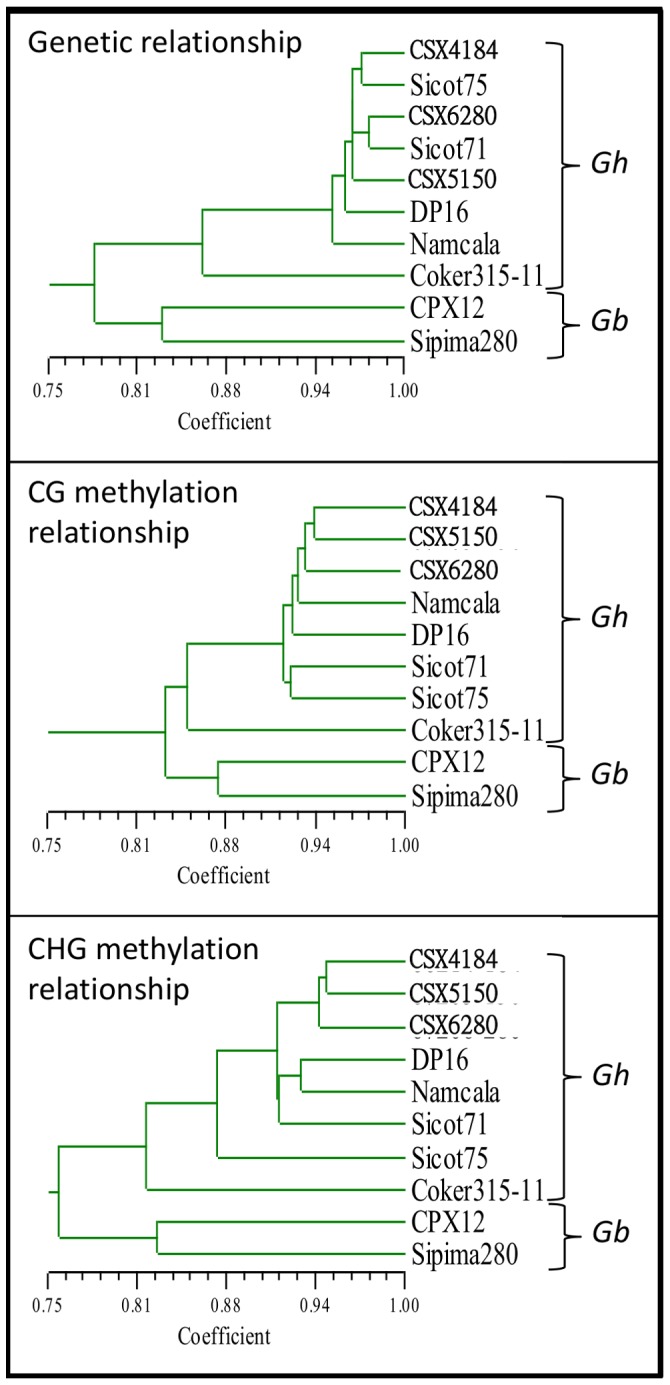
Dendrogram of the ten genotypes constructed using the similarity coefficient.
G. hirsutum species are indicated by “Gh” and G. barbadense species are indicated by “Gb”. The separation of species and Coker 315-11 from other G. hirsutum genotypes is consistent in all dendrograms, but the relationships between G. hirsutum genotypes are different. Separation of genetic, CHG and CG methylation clusters in G. hirsutum genotypes (except Coker 315-11) show clear genetic/DNA methylation divergence in cultivated cotton.